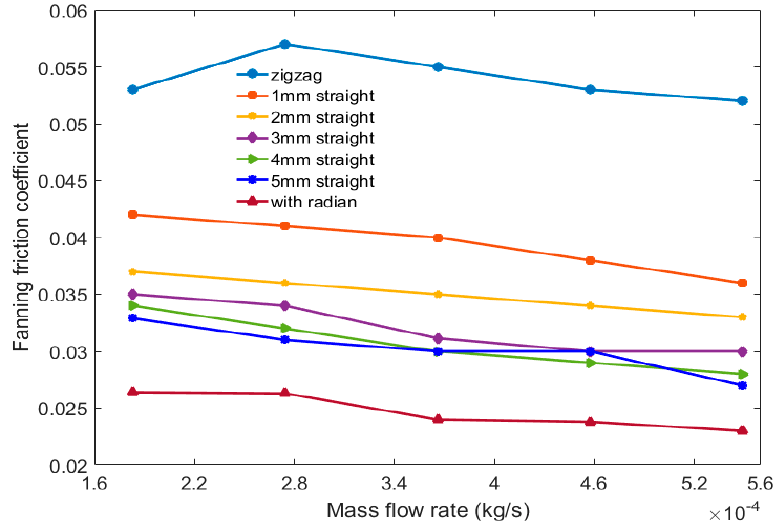
Figure 13. Velocity vectors of Np = 10 at different mass flow rates.